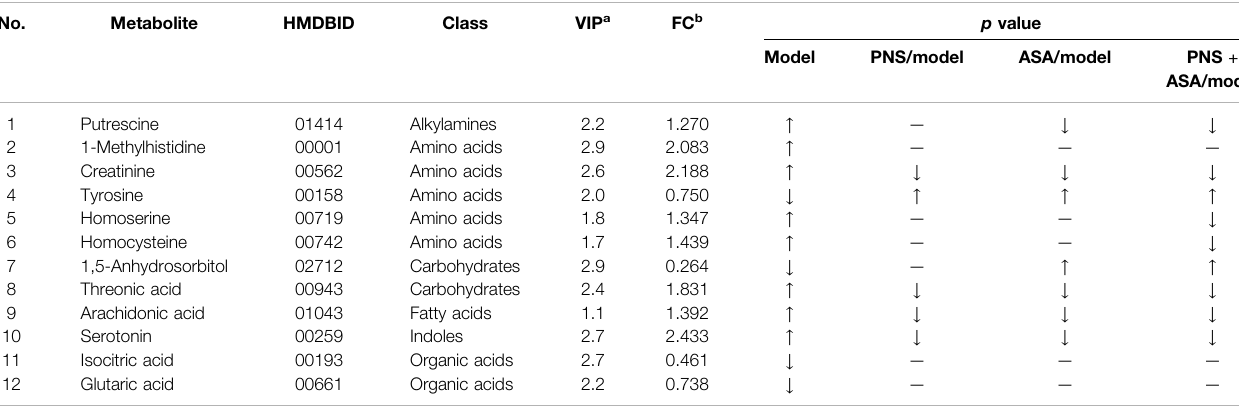
TABLE 1 | Potential discriminatory metabolites of plasma in the rats with acute blood stasis.